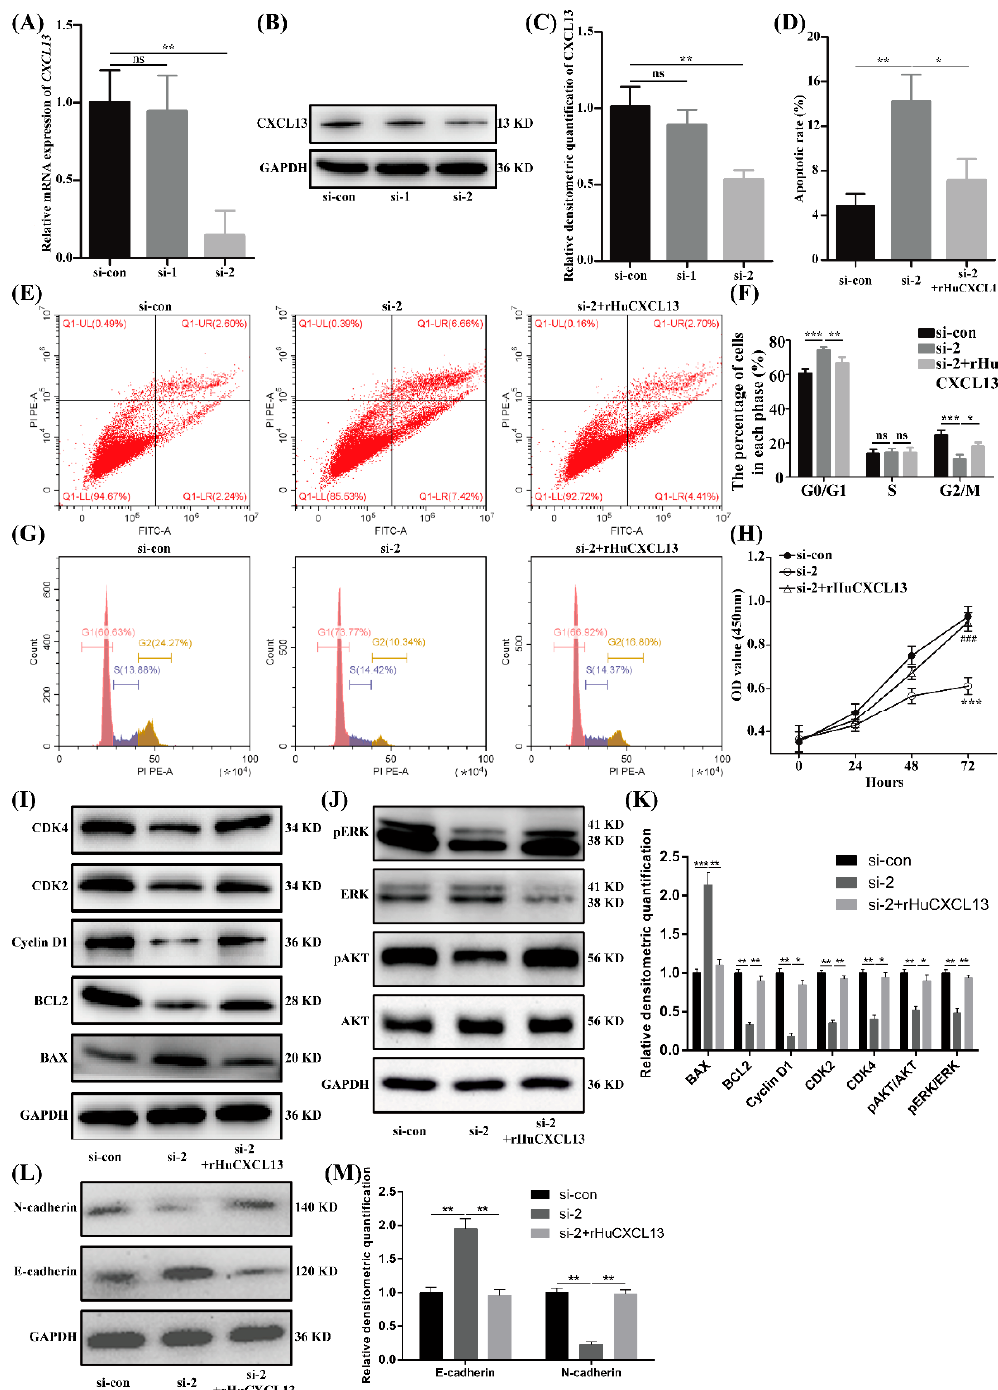
Figure 3. Knockdown of CXCL13 inhibited proliferation, EMT and promoted apoptosis of BPH-1 cells via ERK1/2 and AKT pathway. ( A – C ) Knockdown efficiency of CXCL13 at mRNA and protein levels. ( D , F ) Statistical analysis of apoptotic rate (%) and percentages (%) of cells at each stage. ( E , G ) Flow cytometry analysis of cell apoptosis and cell cycle. ( H ) CCK8 assay of BPH-1 cells. *** means p < 0.001 between si-con and si-2, ### means p < 0.001 between si-2 and si-2+rHuCXCL13. ( I , J ) Western blot assay of cell-cycle-, cell-apoptosis- and pathway-related proteins. ( K ) Relative densitometric quantification of cell-cycle-, cell-apoptosis- and pathway-related proteins. ( L ) Western blot assay of EMT-related proteins. ( M ) Relative densitometric quantification of EMT-related proteins. * p < 0.05, ** p < 0.01, *** p < 0.001 and ns means no significant